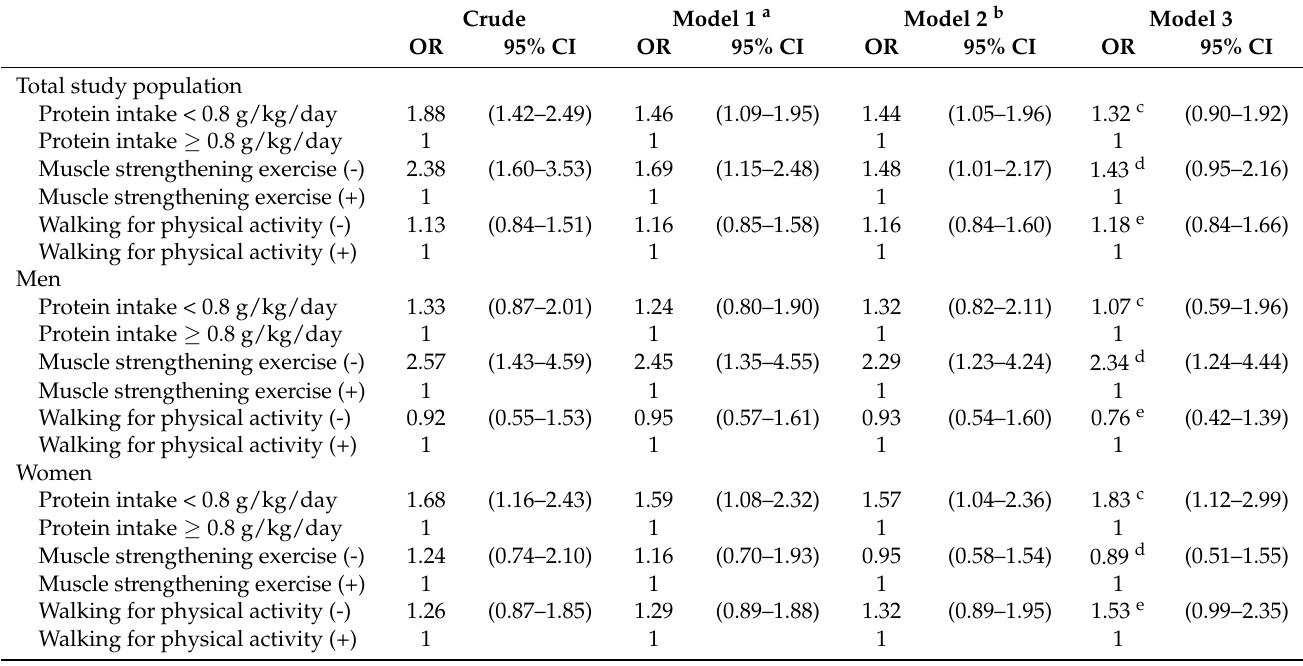
Table 4. Association between protein intake, regular exercise, and low back pain.